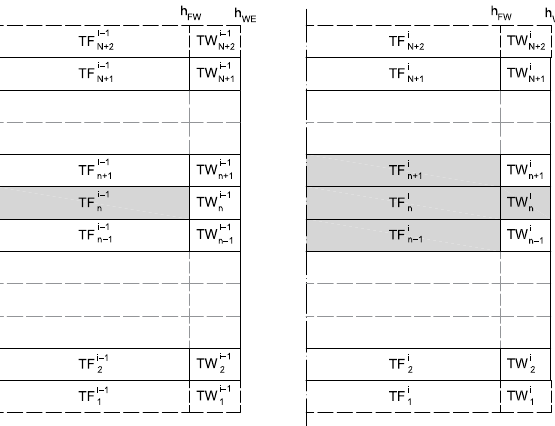
Figure 4. Finite volume model mesh and calculation variables for instant i and layer n . ( Left ): model at instant i − 1. ( Right ): model at instant i . The cells in gray are required for the calculation of T i